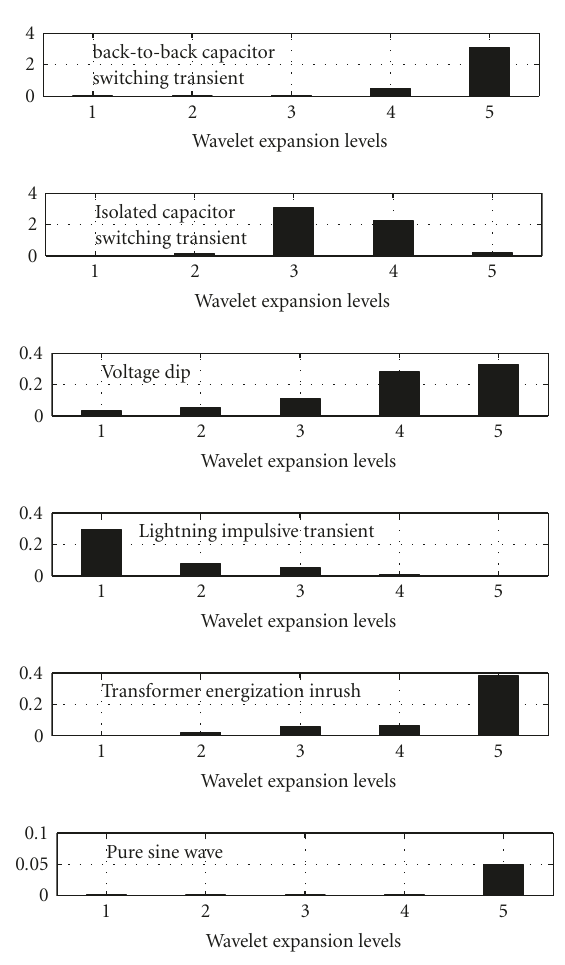
Figure 5: Energy distribution pattern in wavelet domain for various power quality